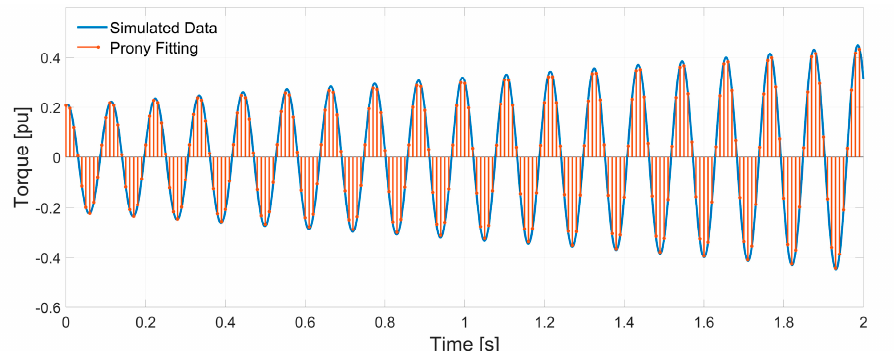
Figure 18. TG shaft-line torque in configuration CC (simulation results).